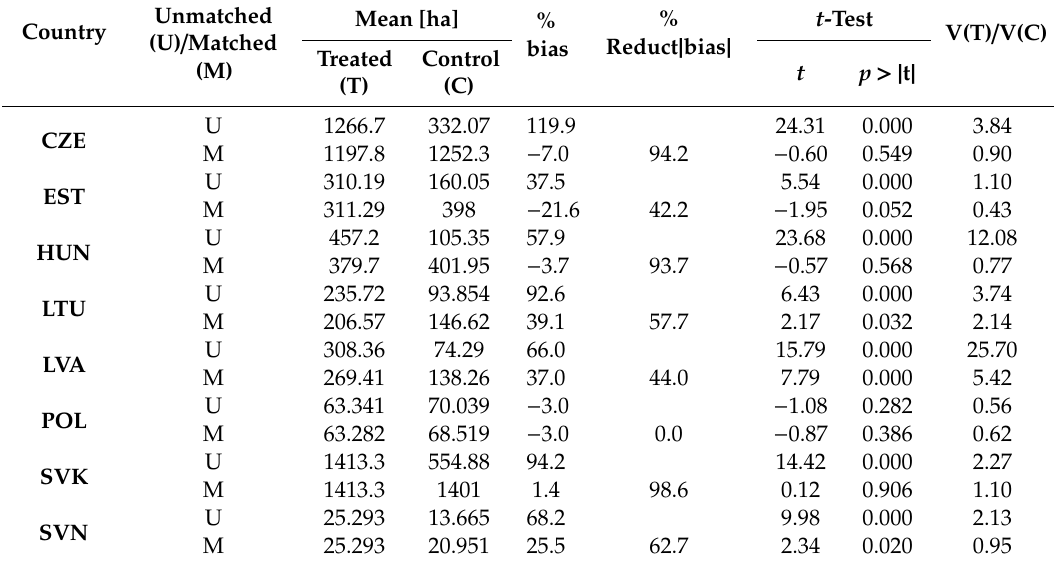
Table 3. Results of the matching procedure for the variable “land” (in ha,